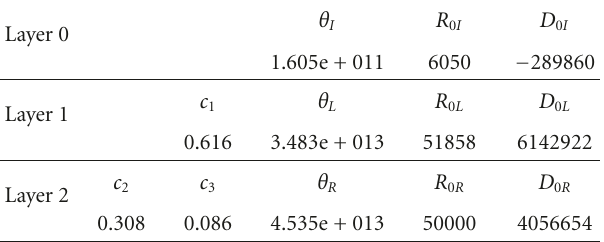
Table 1: Encoder RD curve parameters for “Rena” video.